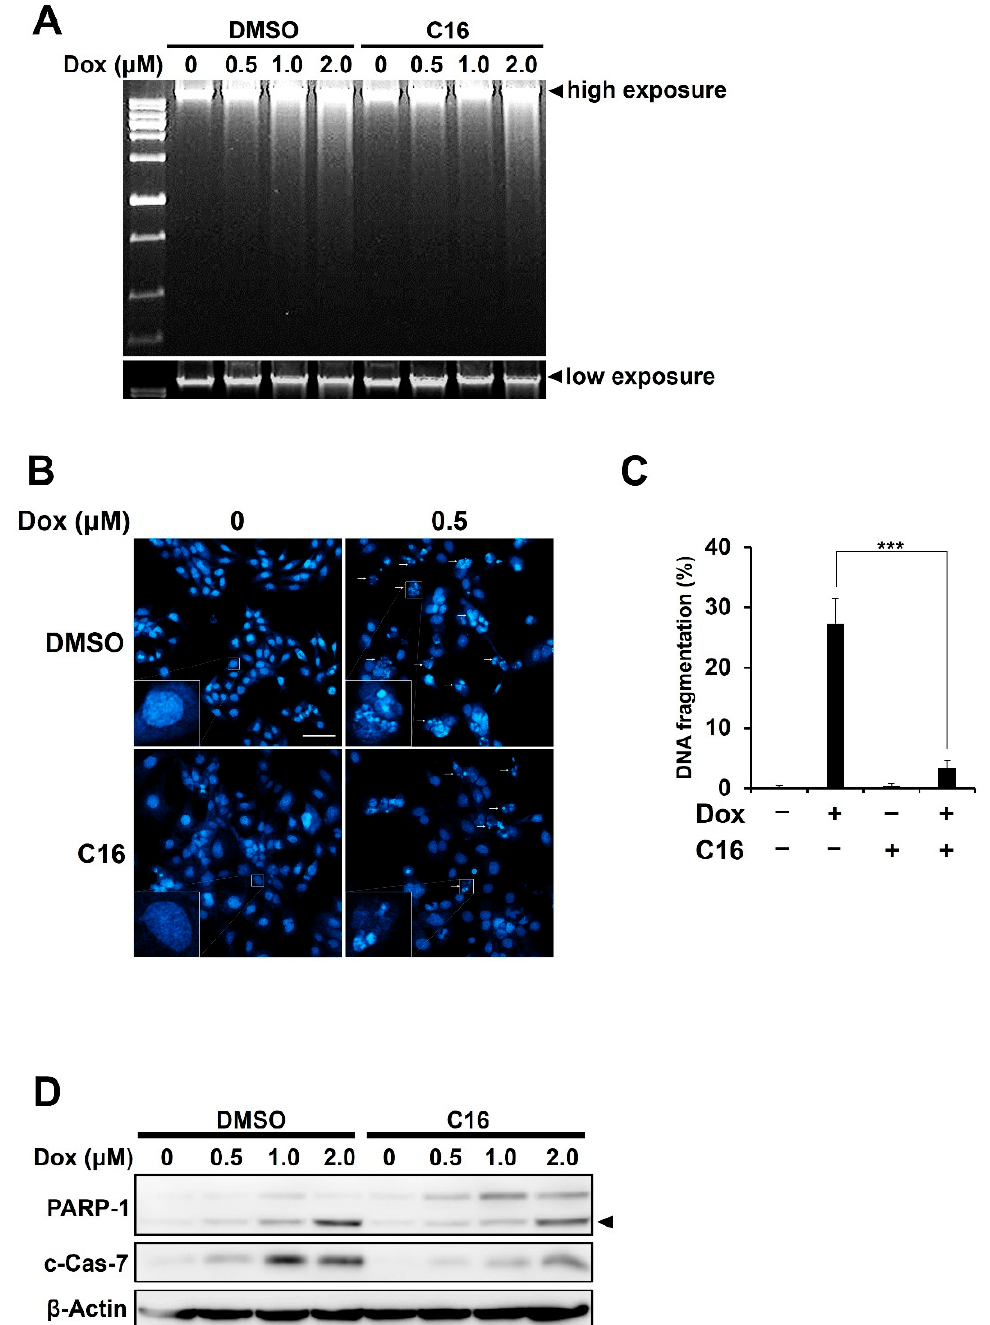
Figure 3. Inhibition of PKR reduces the doxorubicin-mediated apoptosis of HCC1143 cells. ( A ) Cells pretreated with or without 0.5 µM C16 for 1 h were treated with the indicated concentrations of doxorubicin for 48 h. DNA extracted from the cells was electrophoresed on agarose gels. ( B , C ) Cells pretreated with or without 0.5 µM C16 for 1 h were treated with 0.5 µM doxorubicin for 48 h and stained with Hoechst 33342, at room temperature, for 10 min. Nuclear morphological changes were observed using a confocal laser scanning microscope (magnification 100×). Scale bar is 100 µm. Lower-left squares are enlarged representative images ( B ). In each group, fragmented nuclei were counted using a confocal laser scanning microscope. Statistical significance was analyzed via the Student’s t -test (*** p < 0.001) ( C ). ( D ) Cells pretreated with or without 0.5 µM C16 for 1 h were treated with the indicated concentrations of doxorubicin for 32 h and analyzed via immunoblotting using specific antibodies against PARP, c-Cas-7, and β -actin. Arrowhead indicates cleaved form of PARP-1.